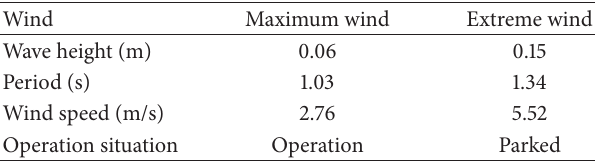
Table 4: Combining a typical wind and a regular wave. Load